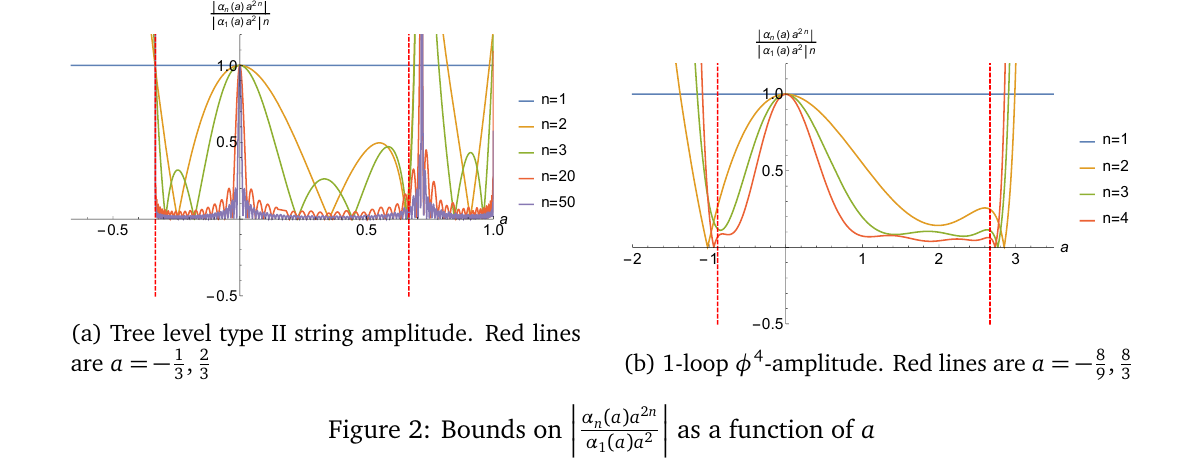
Figure 2: Bounds on